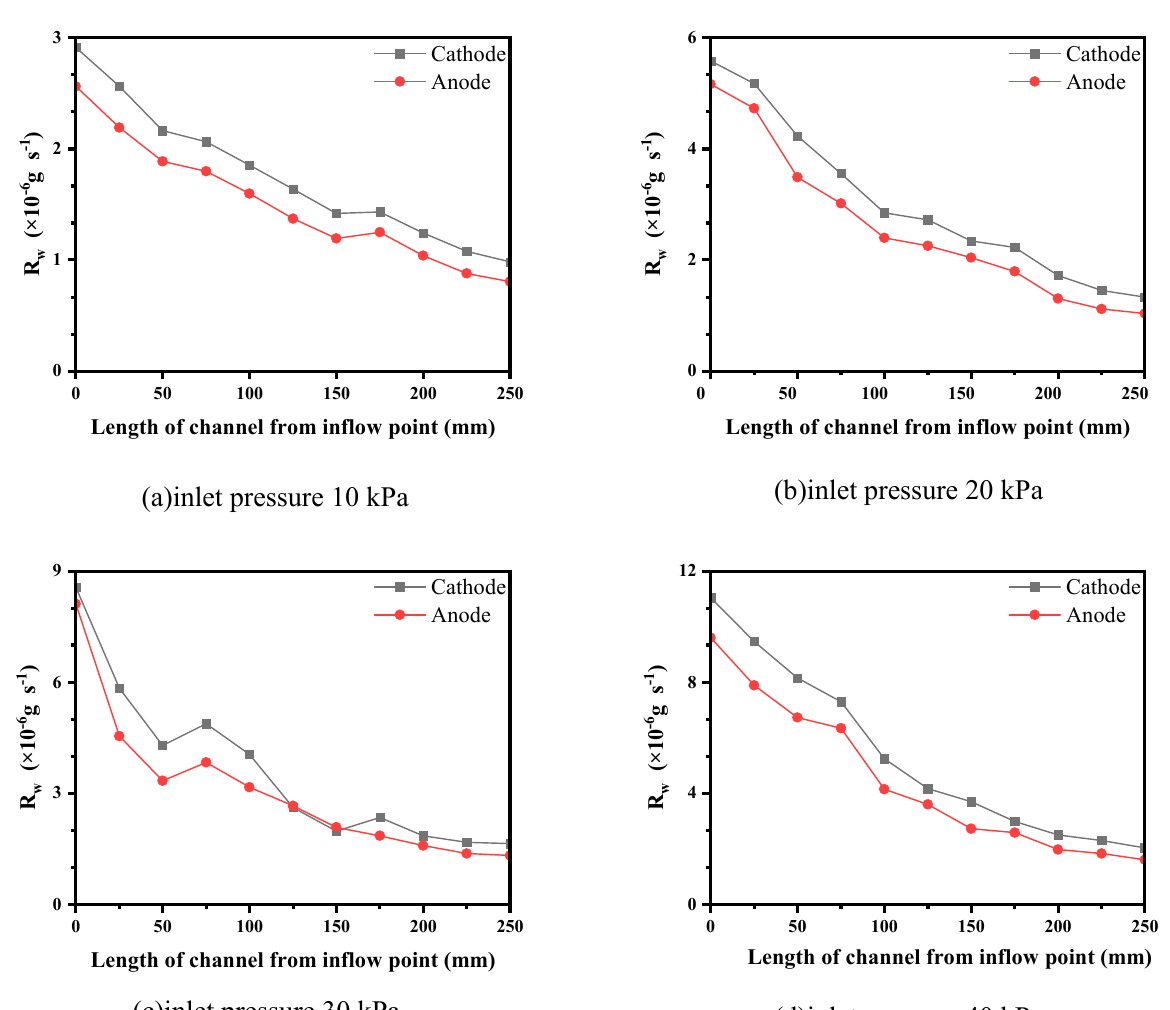
Figure 5. Condensation rate curves in the flow channels under different inlet pressures: ( a ) 10 kPa, ( b ) 20 kPa, ( c ) 30 kPa, ( d ) 40